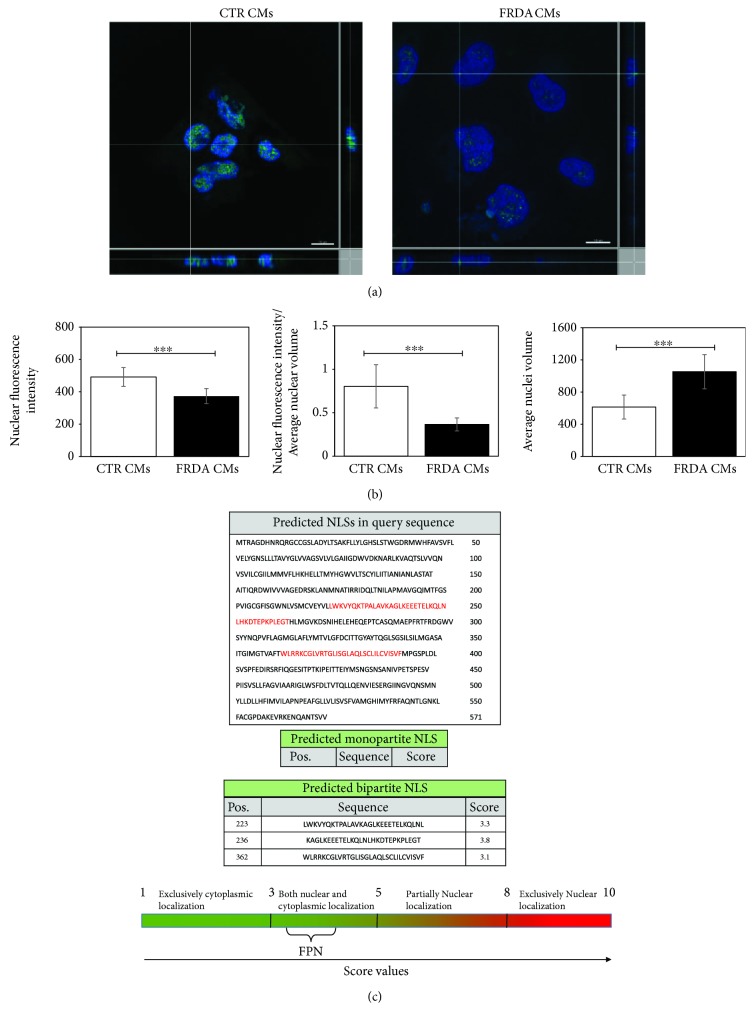
FPN nuclear localization in iPSC-derived CMs. (a) A representative confocal microscopy 3D image projection of FITC-stained FPN (green) protein expression in both CTR and FRDA CMs; the nuclei are counterstained with DAPI (blue). Scale bar equal 10 μm. (b) (i) Quantitative analysis of nuclear FITC fluorescence intensity in both CTR and FRDA CMs, (ii) quantitative analysis of nuclear FITC fluorescence intensity normalized to the average nuclear volume in both CTR and FRDA CMs, and (iii) average nuclear volume in both CTR and FRDA CMs; ∗∗∗
p < 0.001. (c) Bioinformatic analysis of FPN (NP_055400), using cNLS Mapper, predicted three bipartite NLS with a score value >3 indicating that the protein localizes both in the nucleus and in the cytoplasm.